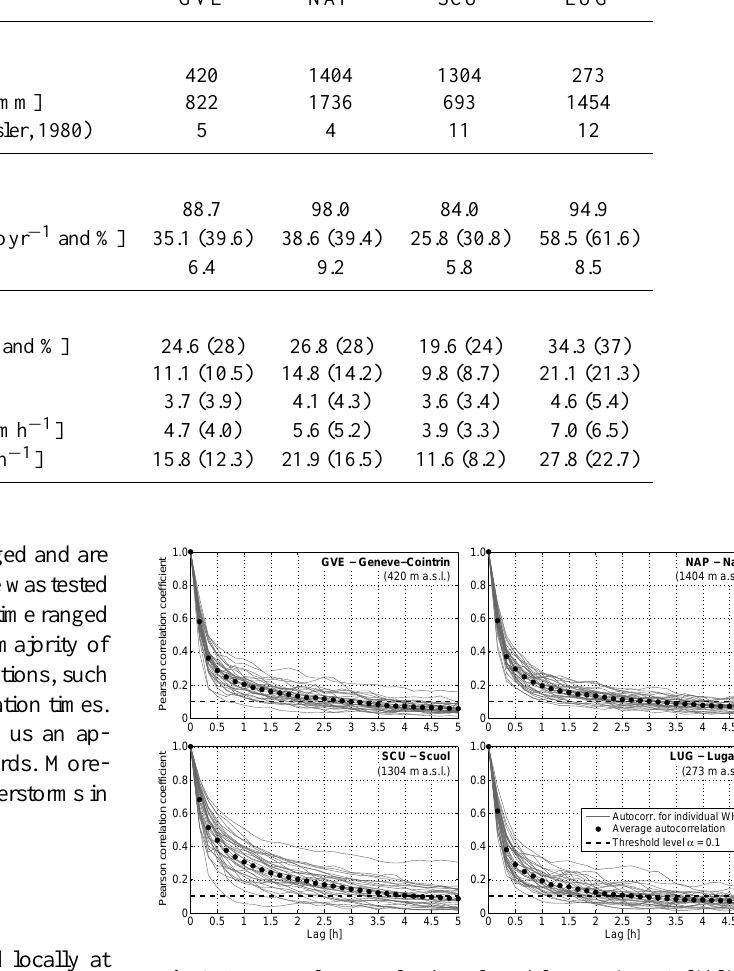
Fig. 3. Autocorrelograms for the selected four stations. Solid lines represent the autocorrelation coefficients for the individual warm half years (abbr. WHY) with lags of 10min. The dots show the av- erage of the autocorrelation functions over all years. The dashed horizontal straight line is the critical correlation for the significance level